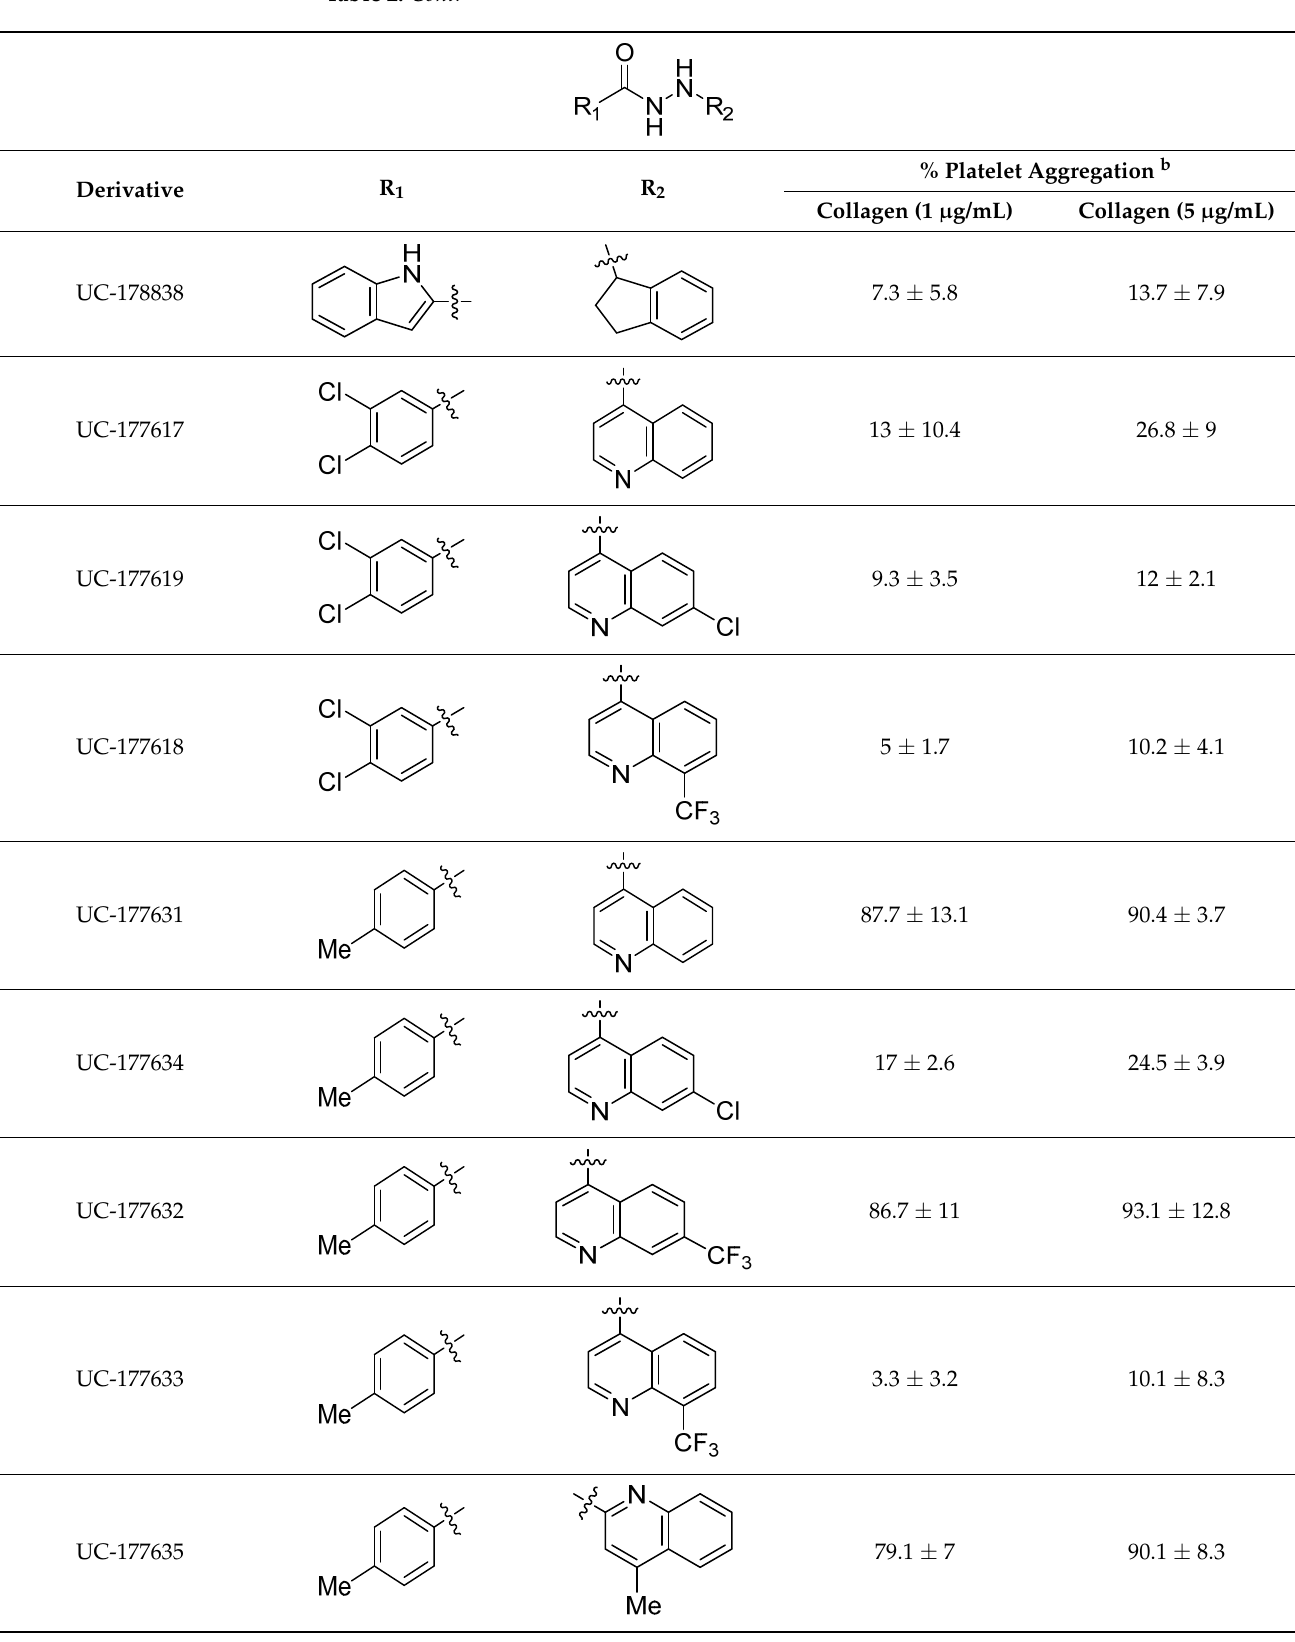
Table 2. Structures of compound UC-177629 analogs and their effects at 20 µM on in vitro collagen- induced platelet aggregation.